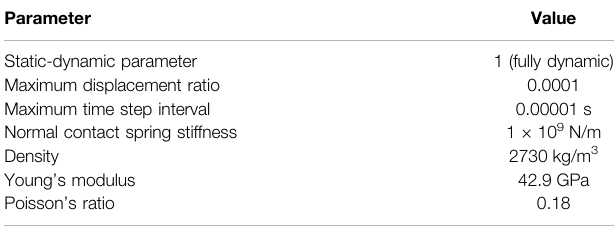
TABLE 1 | Numerical and physical parameters used for 3-D DDA veri fi cation study.